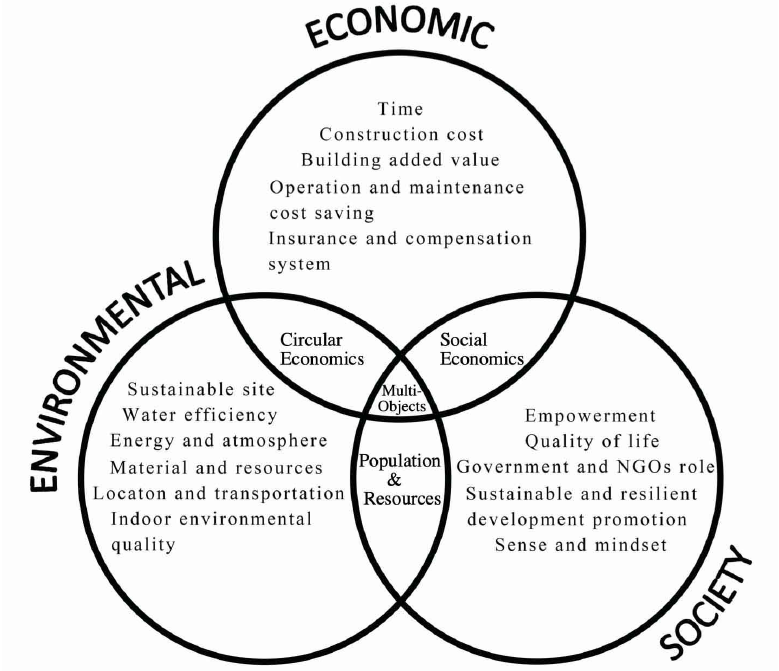
Figure 9. Sustainable retrofit